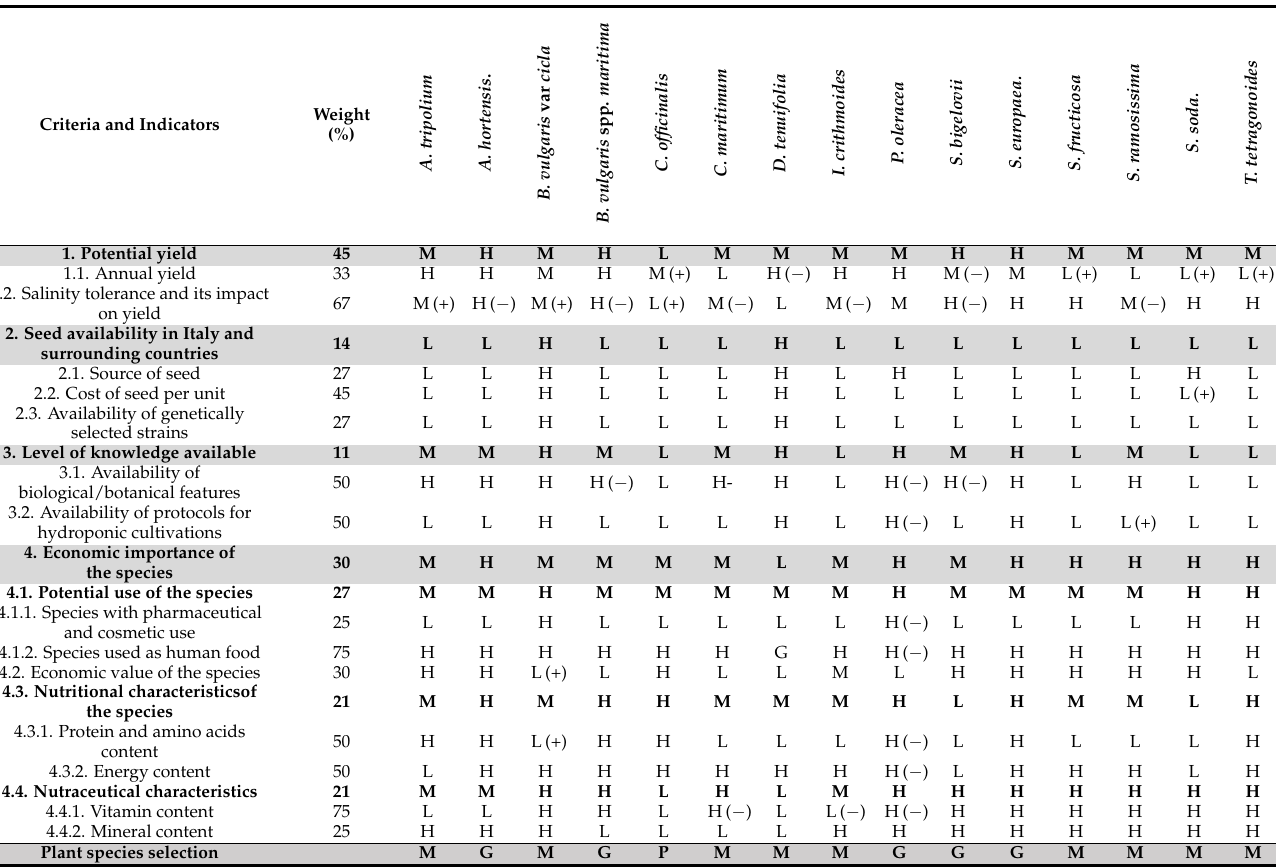
Bold letters indicate aggregated criteria or sub-criteria; grey highlighted rows indicate criteria; symbols means that a ‘plus/minus 1’ change in the indicator’s score affects the ‘Plant species selection’ value positively (+) or negatively ( − ); H: High, M: Medium, and L: Low for criteria score; G: Good, M: Medium, P: Poor, and U: Unac-